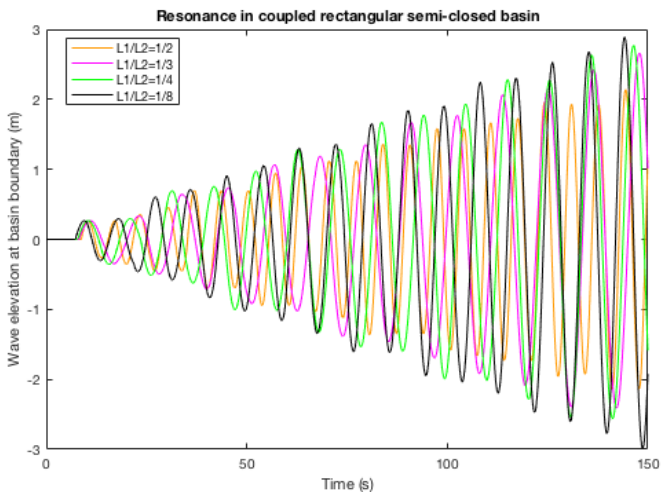
Figure 10. Simulation results for coupled rectangular semi-closed